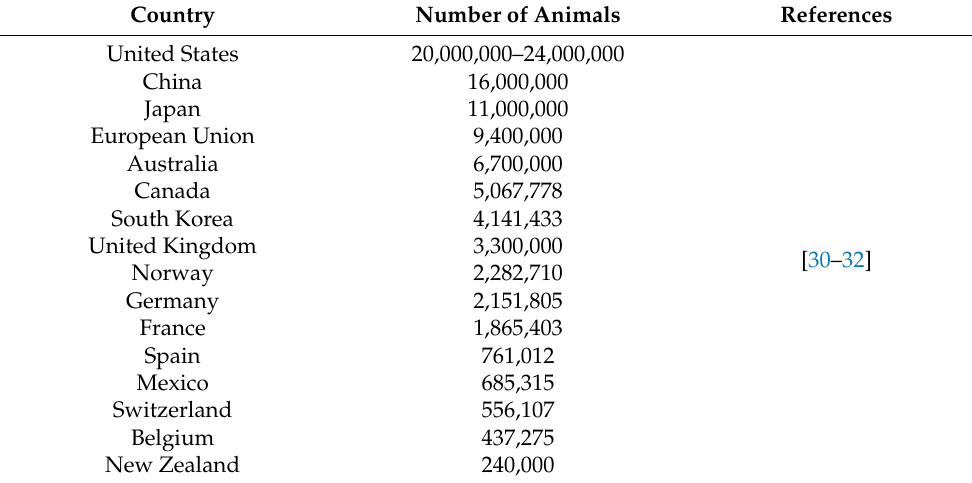
Table 2. Approximate of the number of animals used in research worldwide between 2019–2020.